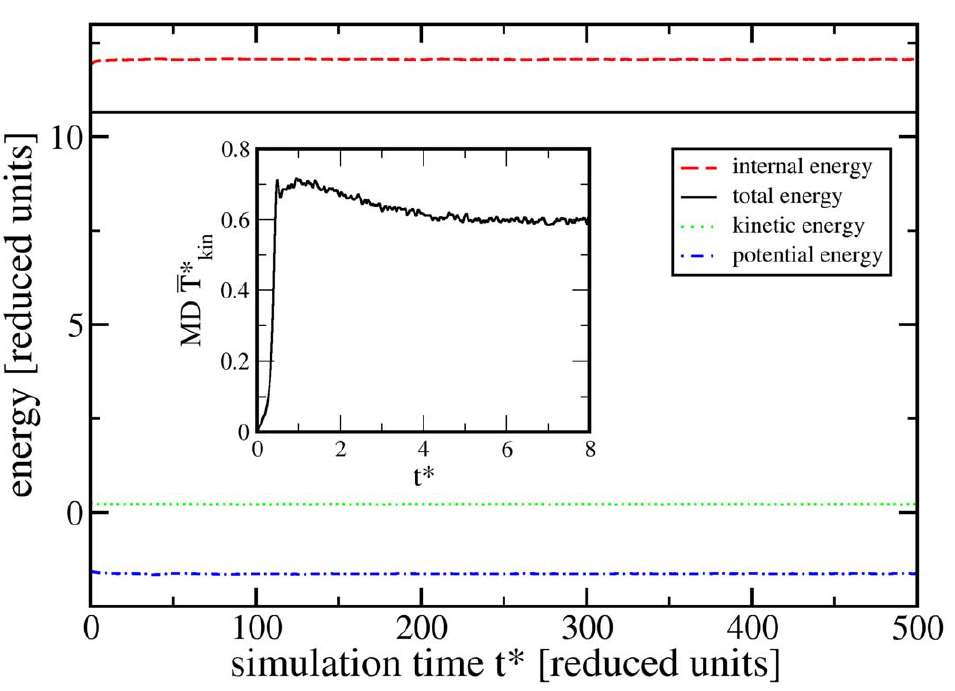
Figure 2. Time-evolution of potential, kinetic, and internal energies corresponding to the temperature equilibrium problem. The inset shows the initial equilibration of the MD/DPDE kinetic temperature.